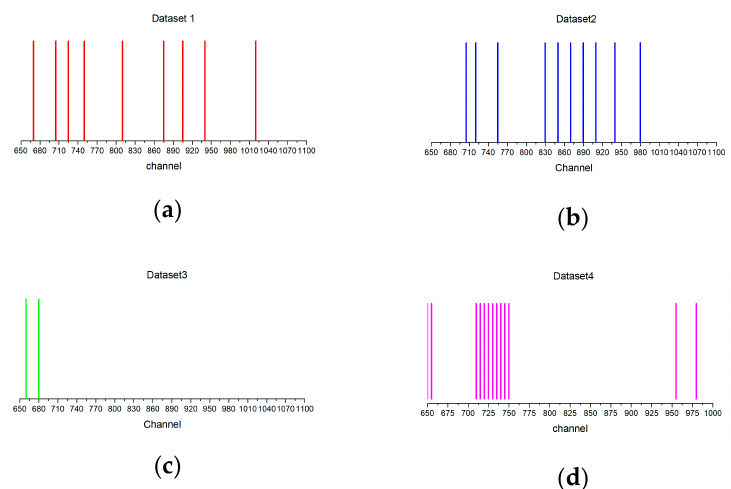
Figure 4. The selected bands with echo maximum by naïve Bayes (NB) classifier. ( a ) Dataset 1; ( b ) Dataset 2; ( c ) Dataset 3; and ( d ) Dataset